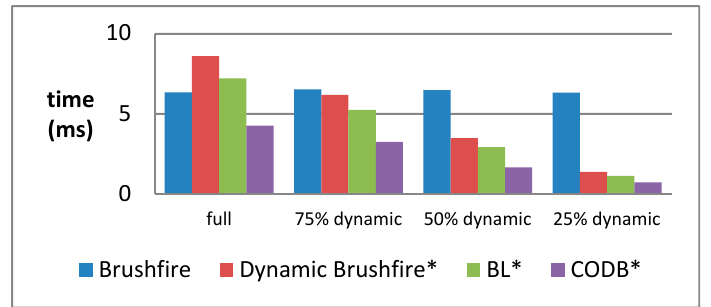
Figure 10. The average computation time provided by the four algorithms for updating DMs. The algorithms prefixed with "*" are dynamic algorithms and only update the affected areas.